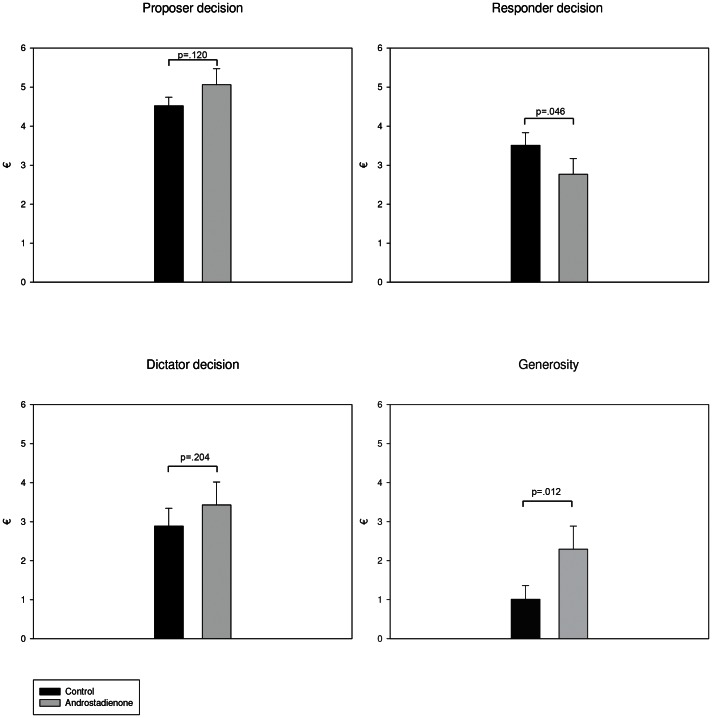
Estimated marginal means for the decision making variables.
Error bars represent standard error.